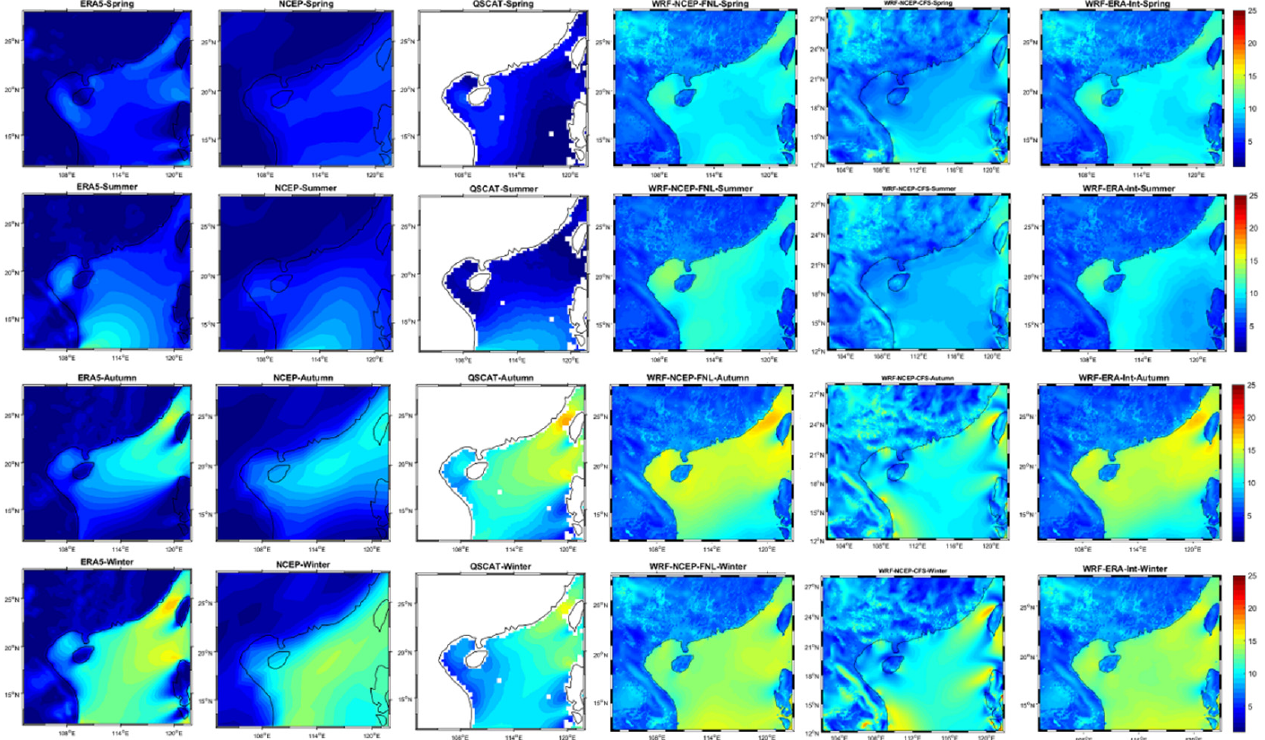
Figure 10. Average seasonal wind speed in m s − 1 from the models and observations for all the seasons along the study area. Spring is shown in first row, summer in second row, autumn in third row and winter in fourth row. The first column represents ERA5 data, second column from NCEP Reanalysis 2, third column from QuikScat, fourth column from WRF-N simulations, fifth from WRF-C simulations and sixth from WRF-E